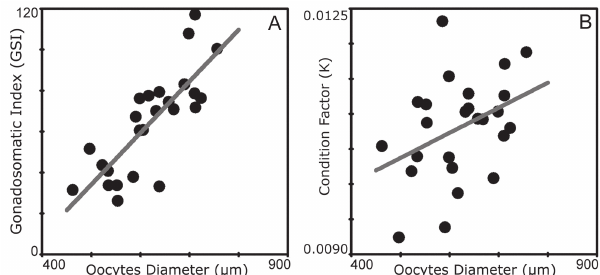
Fig. 11. Relation between the oocytes mean diameter with the gonadosomatic index (A) and with the condition factor (B) of Cetengraulis edentulus in Guanabara Bay. Lines represent the generalized additive models selected by the Akaike information